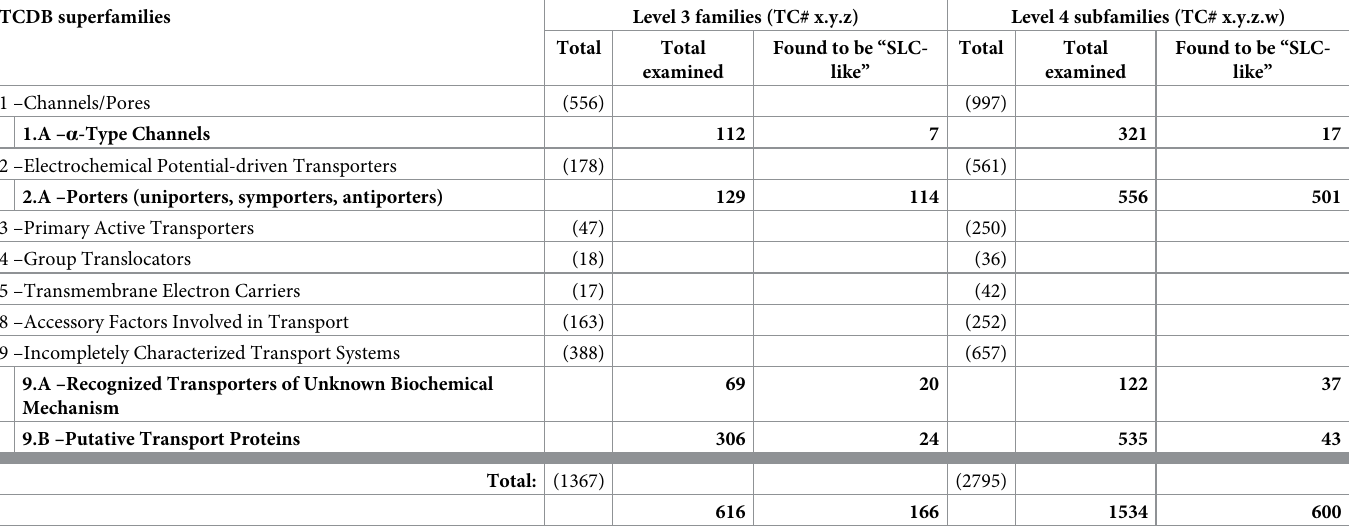
Table 1. Families and subfamilies examined from the TCDB for SLC-like proteins. Superfamilies marked in boldface have been analyzed. The superfamily #1.A was examined since several existing SLC families are classified here, while superfamily #2.A was expected to contain most known SLC proteins. Superfamilies #9.A and #9.B were also examined. Total number of families and subfamilies in the first-level classes are indicated in parentheses. Numbers show the total number of level 3 families and level 4 subfamilies in each superfamily, as well as those found to be “SLC-like” (see